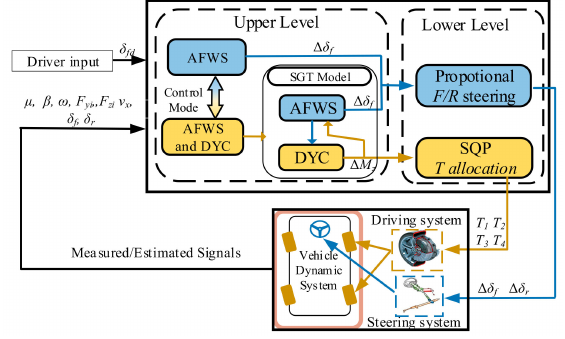
Figure 1. Overall hierarchical control